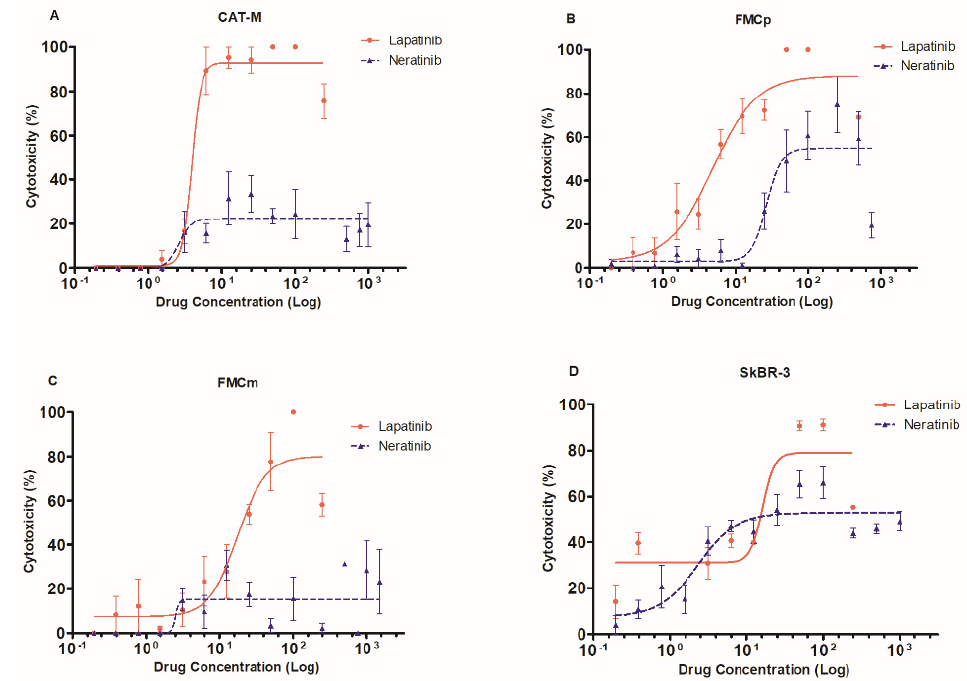
Figure 1. Lapatinib and neratinib showed strong cytotoxic effects in feline mammary carcinoma cell lines. ( A ) CAT-M cell line presented higher cytotoxic effects when incubated with lapatinib (IC 50 = 3930 nM ± 49) than with neratinib. ( B ) FMCp cell line was susceptible to both lapatinib and neratinib (100% and 74.9% of cytotoxicity, respectively; IC 50 = 4870 nM ± 100 for lapatinib). ( C ) FMCm cell line also showed high cytotoxic effects in the presence of lapatinib (IC 50 = 17,470 nM ± 100), contrasting with the neratinib. ( D ) SkBR-3 cells showed a maximum cytotoxic effect of 91.1% (IC 50 = 16,220 nM ± 1040) after exposure to lapatinib and 66.0% when exposed to neratinib. For graphical convenience, lapatinib was represented in a µ M range, while neratinib was defined in a nM range. The experiments were performed in triplicates, in three independent